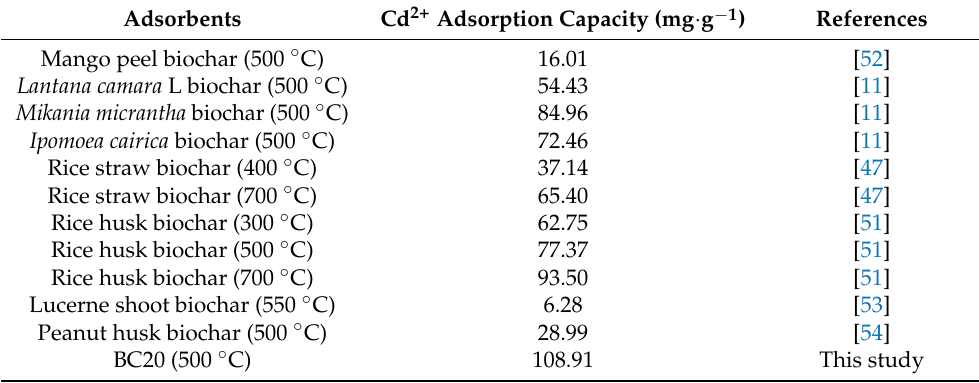
Table 5. Comparison of Cd 2+ adsorption capacity ( Q m ) with other reported